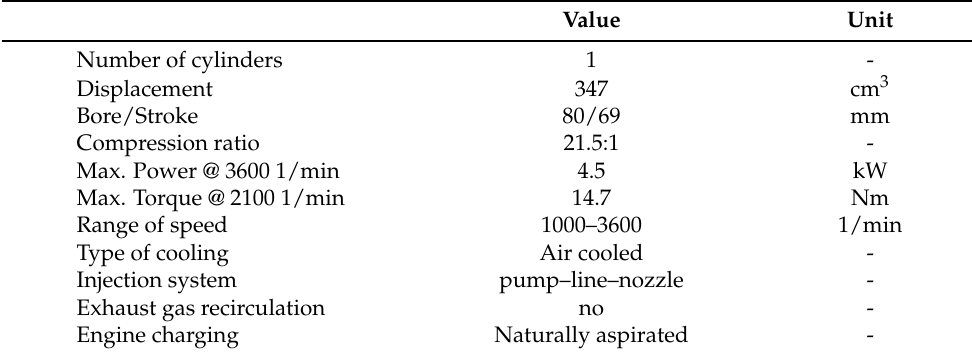
Table 2. Parameters of the test